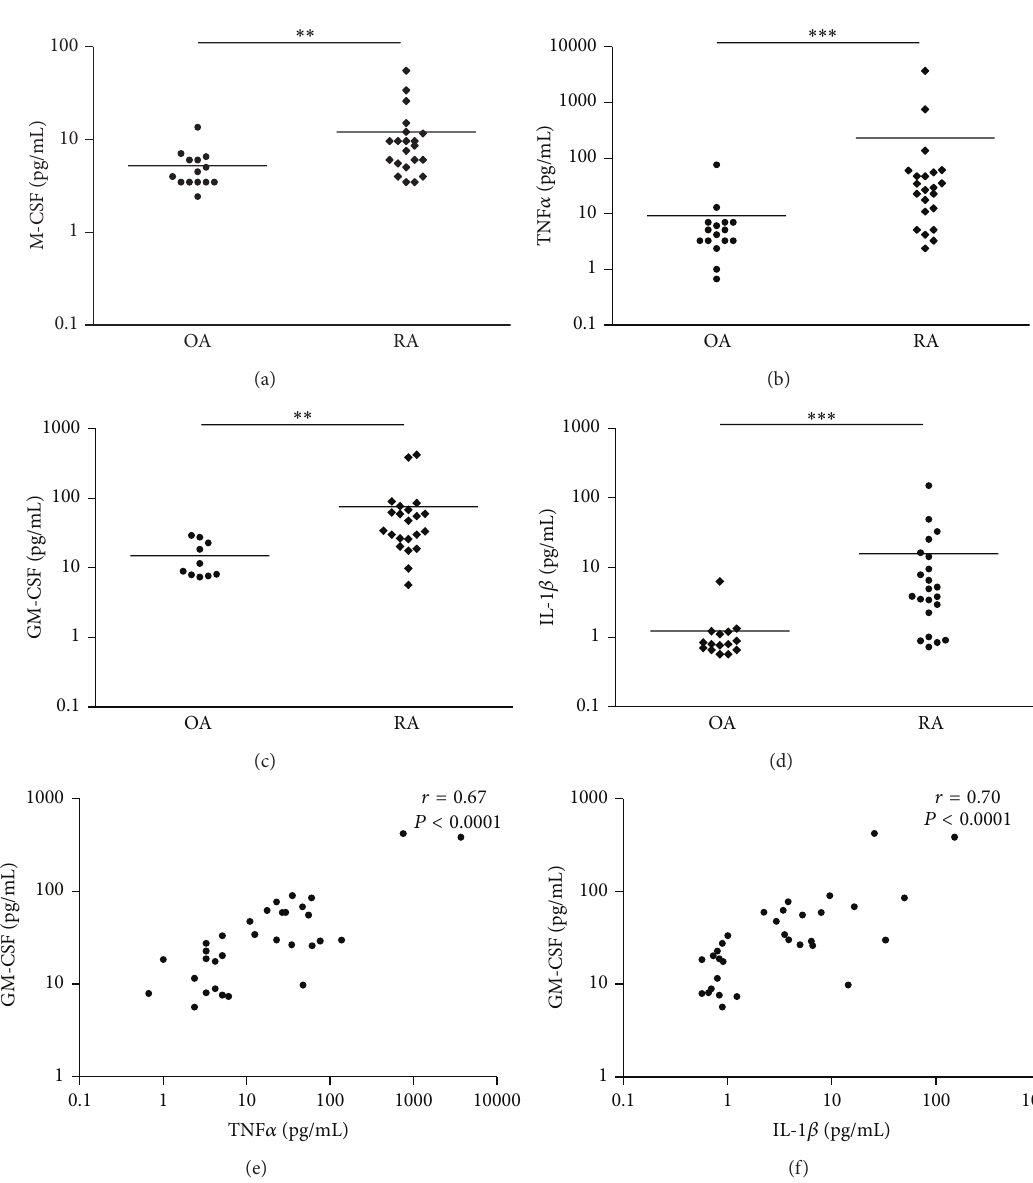
Figure 5: MCSF, GM-CSF, TNF 𝛼 , and IL-1 𝛽 concentrations are increased in the synovial fluid of RA patients . (a)–(d) MCSF, GM-CSF, TNF 𝛼 , and IL1 concentration was assessed in synovial fluid of RA ( 𝑛 = 21 ) and OA ( 𝑛 = 14 ) patients using the Luminex technology. Each dot represents one patient and the bar indicates the mean concentration. ∗∗ 𝑃 < 0.001 ; ∗∗∗ 𝑃 < 0.0001 . (e)-(f) Scatter plot showing the correlation between TNF 𝛼 , IL-1 𝛽 , and GM-CSF concentration. 𝑟 = correlation coefficient measured using the nonparametric Spearman rank order